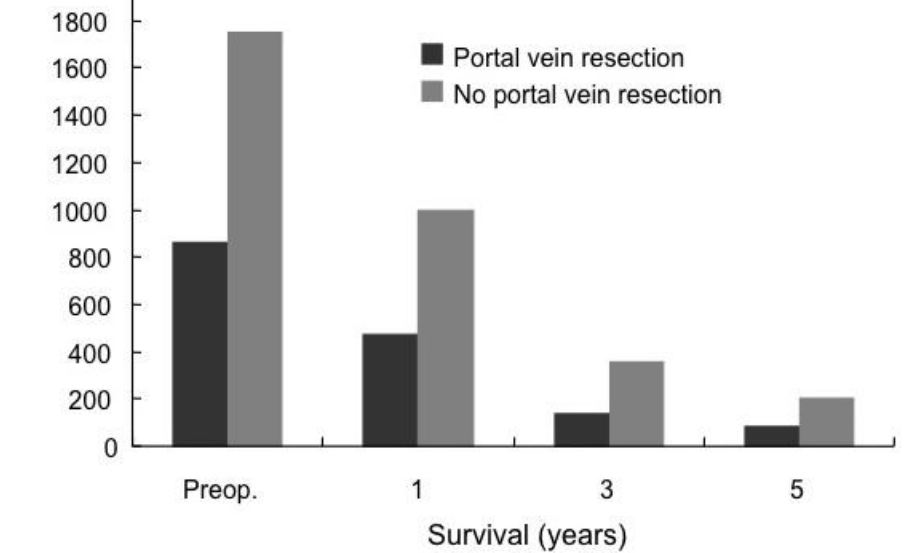
Figure 6. Comparison of survival in patients with or without portal vein resection (PVR). The blocks represent the total numbers of known survivors at each time interval. Comparisons were drawn by pooling data from 23 studies that had outcome data for pancreatectomy with portal vein resection. Note that this is not a parallel comparison of pancreatectomy with PVR in patients with tumor involvement versus pancreatectomy without PVR with tumor involvement, and patients without PVR are likely to have had earlier stage disease (from [16]).